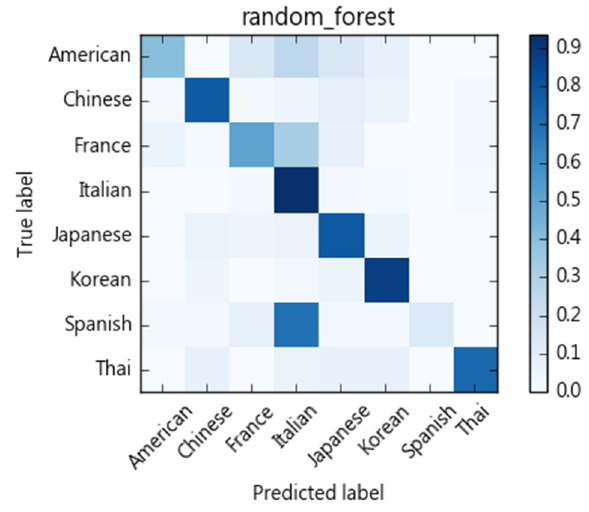
Figure 8. Confusion matrix of the random forest classifier.